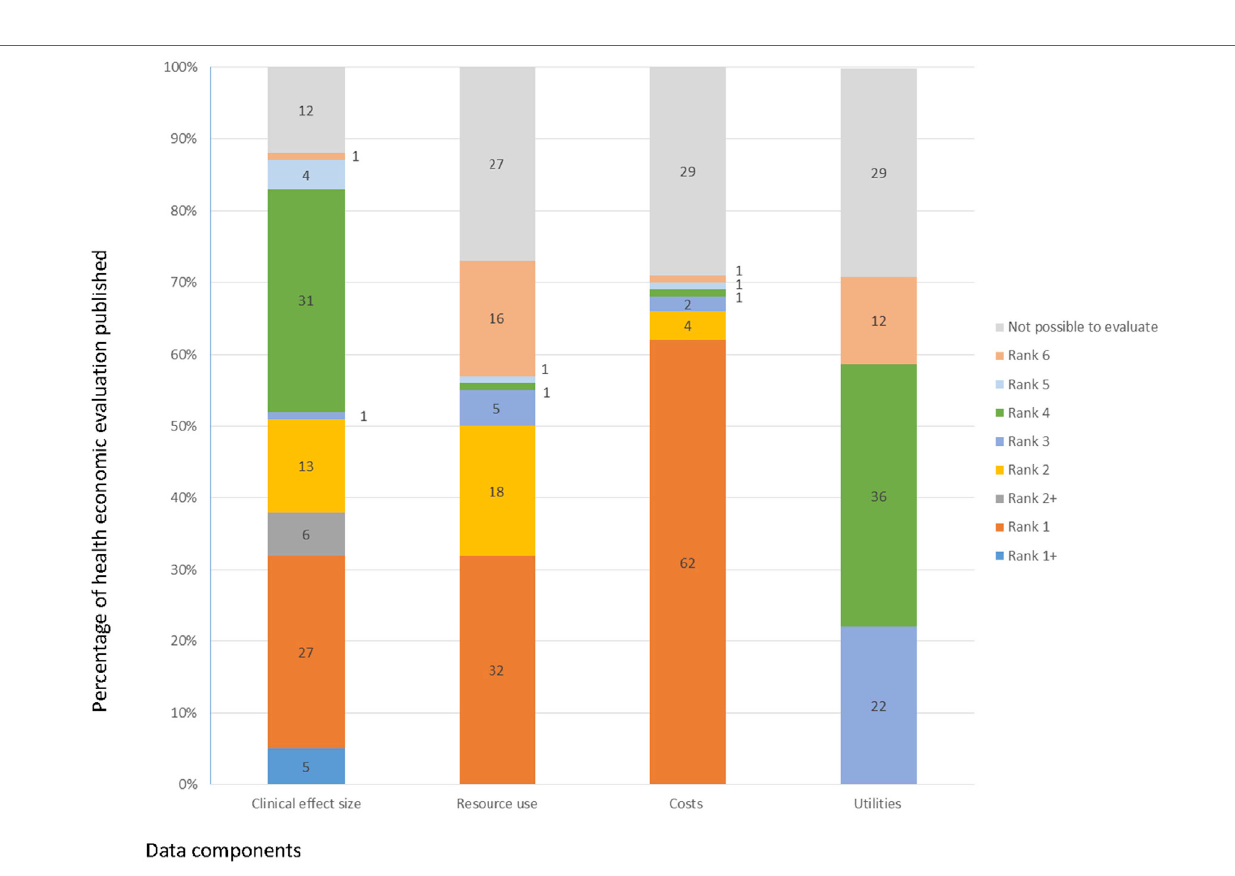
FiGURe 6 | Quality of the sources of evidence used in the full health economic evaluation ( n = 197), Brazil,